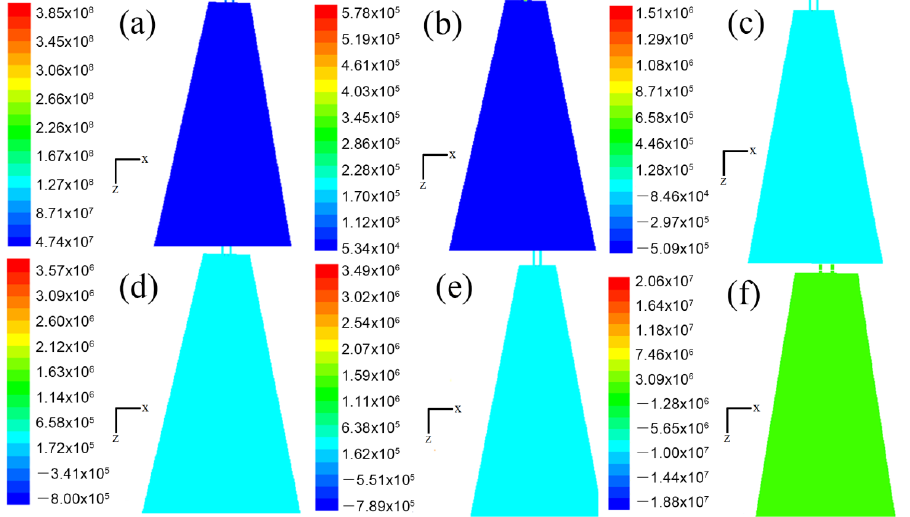
Figure 7. Pressure cloud distribution on the x–z plane (Pa): ( a ) velocity cloud distribution of flow field at time t = 1.000 × 10 − 7 s; ( b ) velocity cloud distribution of flow field at time t = 1.600 × 10 − 6 s; ( c ) velocity distribution of flow field at time t = 2.979 × 10 − 5 s; ( d ) velocity cloud distribution of flow field at time t = 1.338 × 10 − 4 s; ( e ) velocity cloud distribution of flow field at time t = 6.013 × 10 − 3 s; ( f ) velocity cloud distribution of flow field at time t = 1.543 × 10 − 2 s.